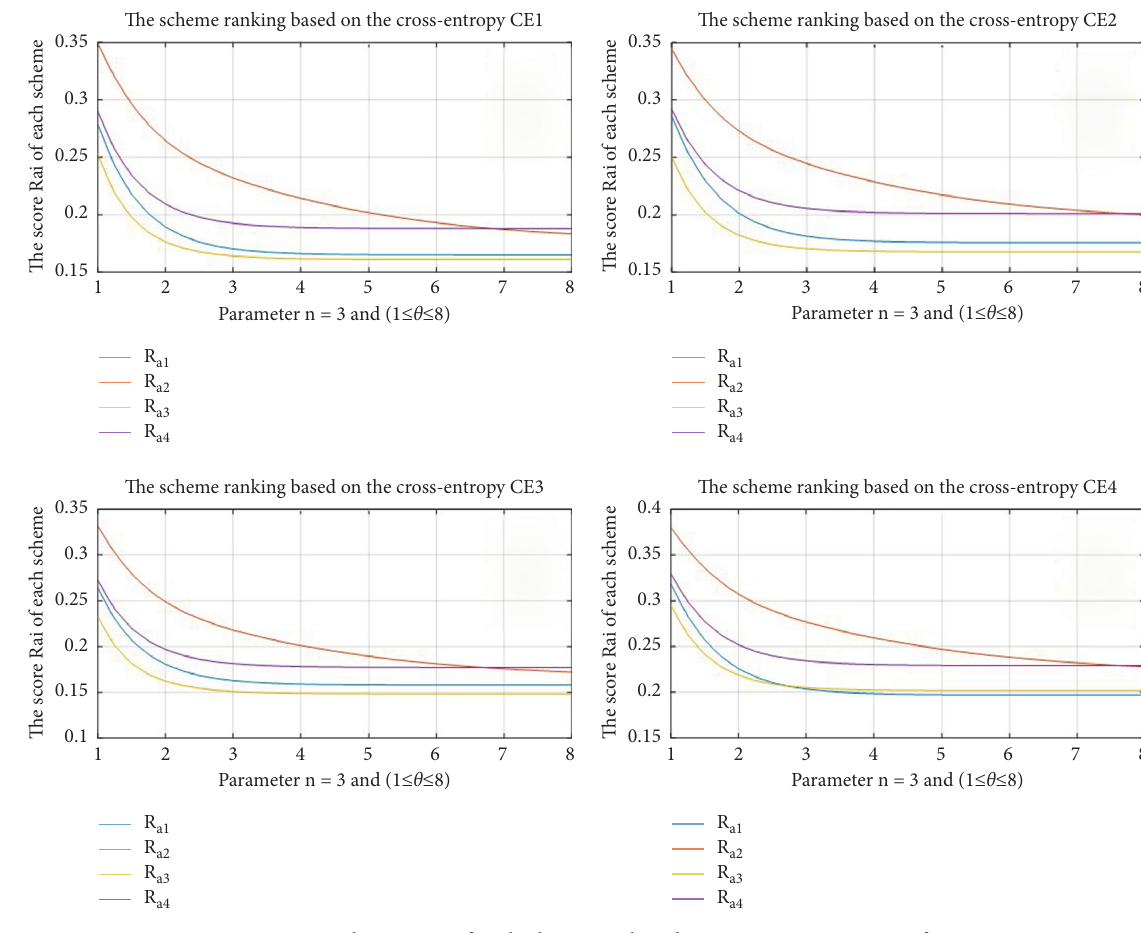
Figure 12: Ranking score of each alternative based on parameters n � 3, 1 ≤ θ ≤